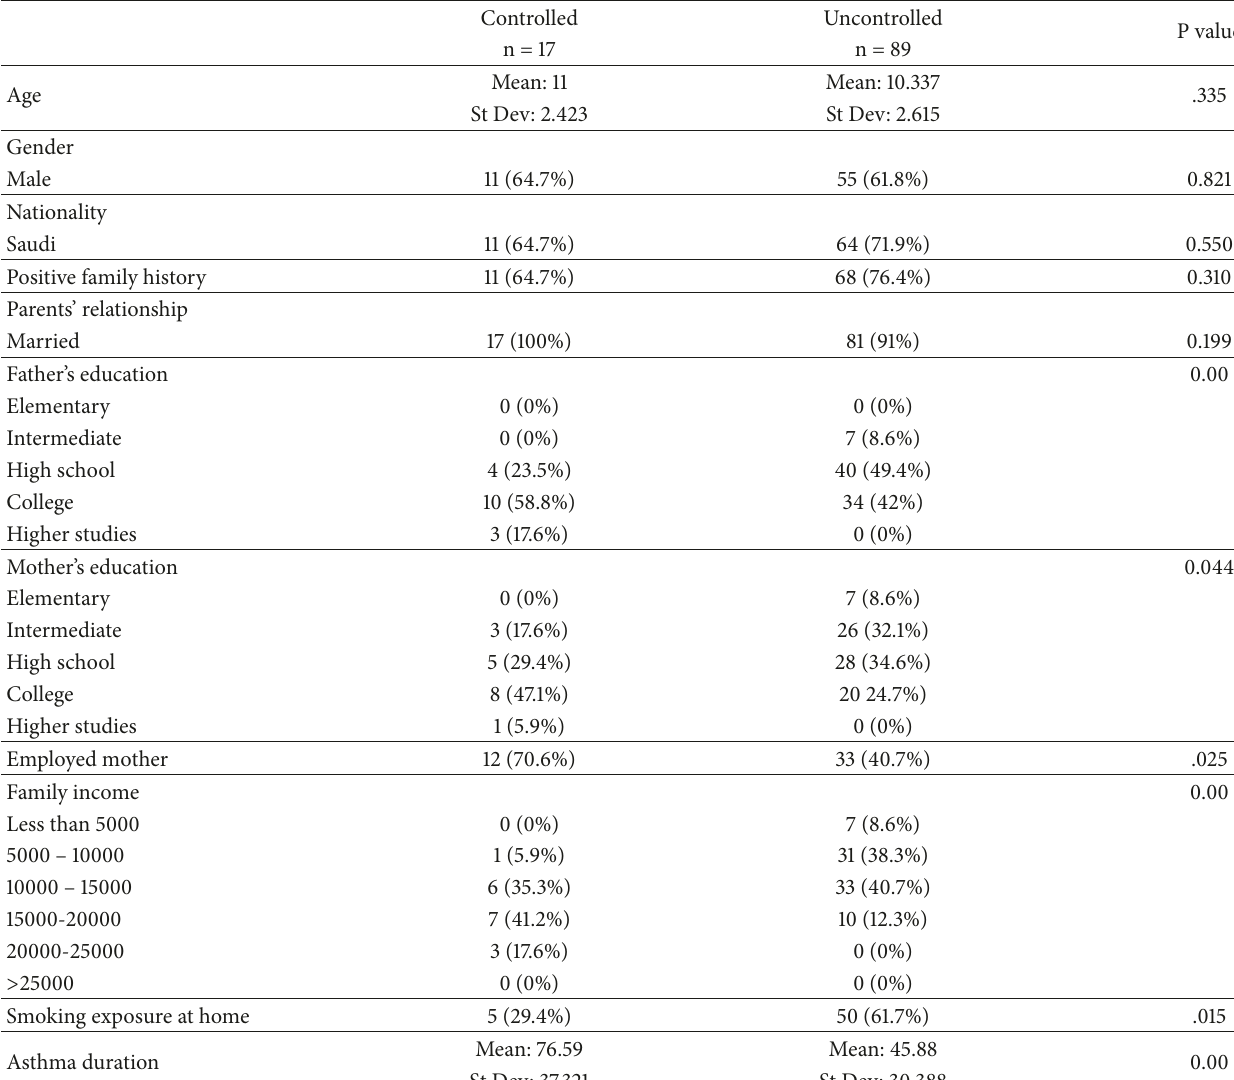
Table 1: Sociodemographic characteristics of the